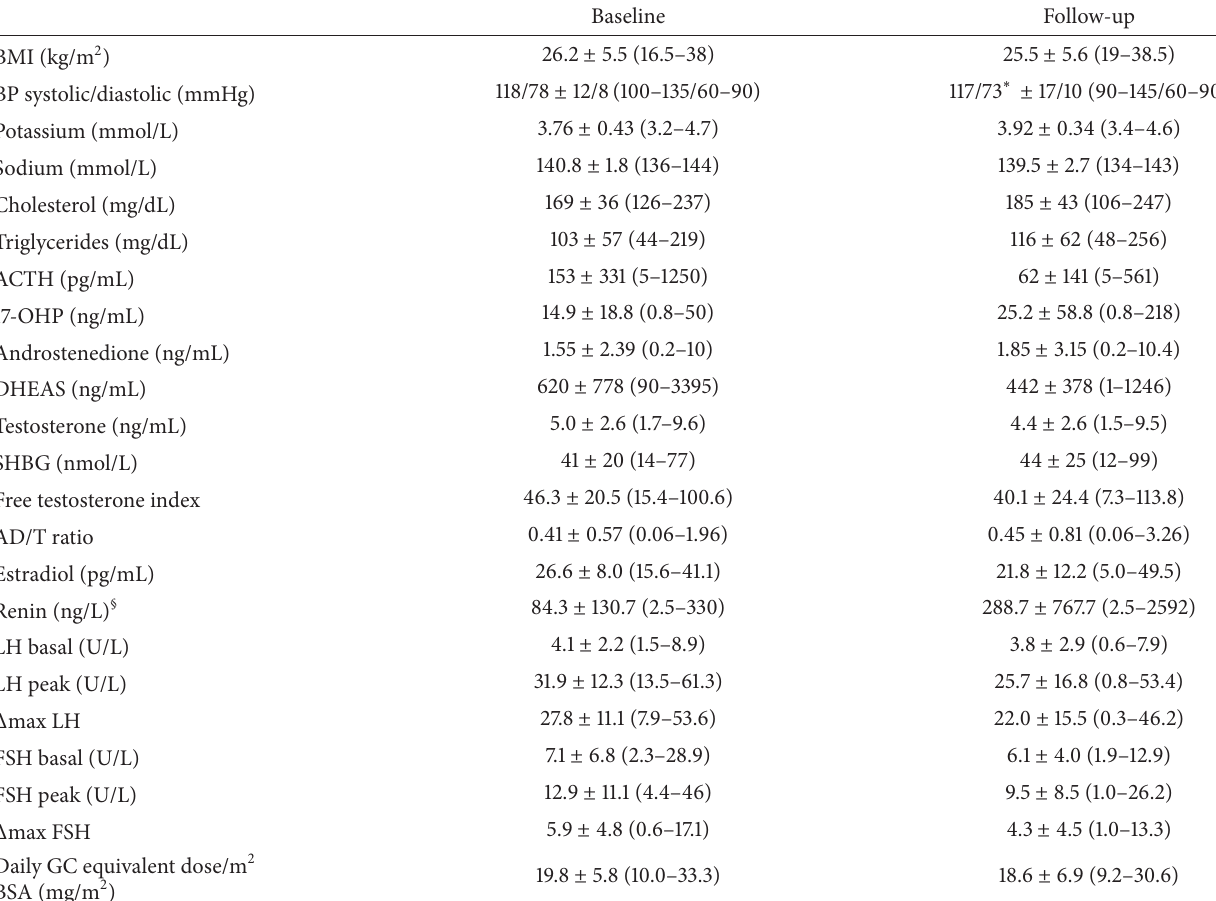
Table 2: Biochemical and hormonal parameters in 17 male patients with 21-OHD at study start (baseline) and after 2-year follow-up.